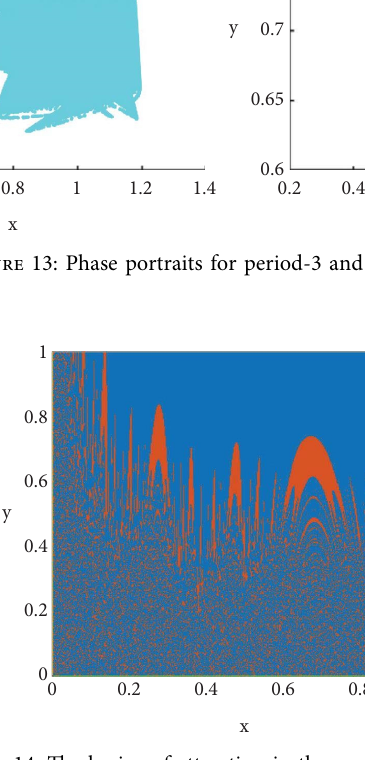
Figure 14: Te basins of attraction in the x − y initial plane.